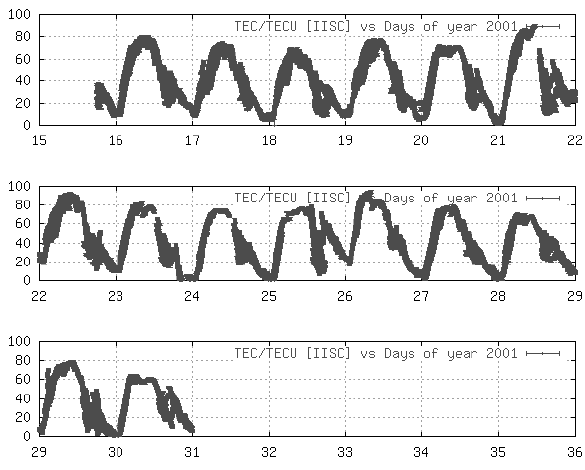
Fig. 5. Variations of the TEC data recorded by the Bangalore station during the second half of January 2001.